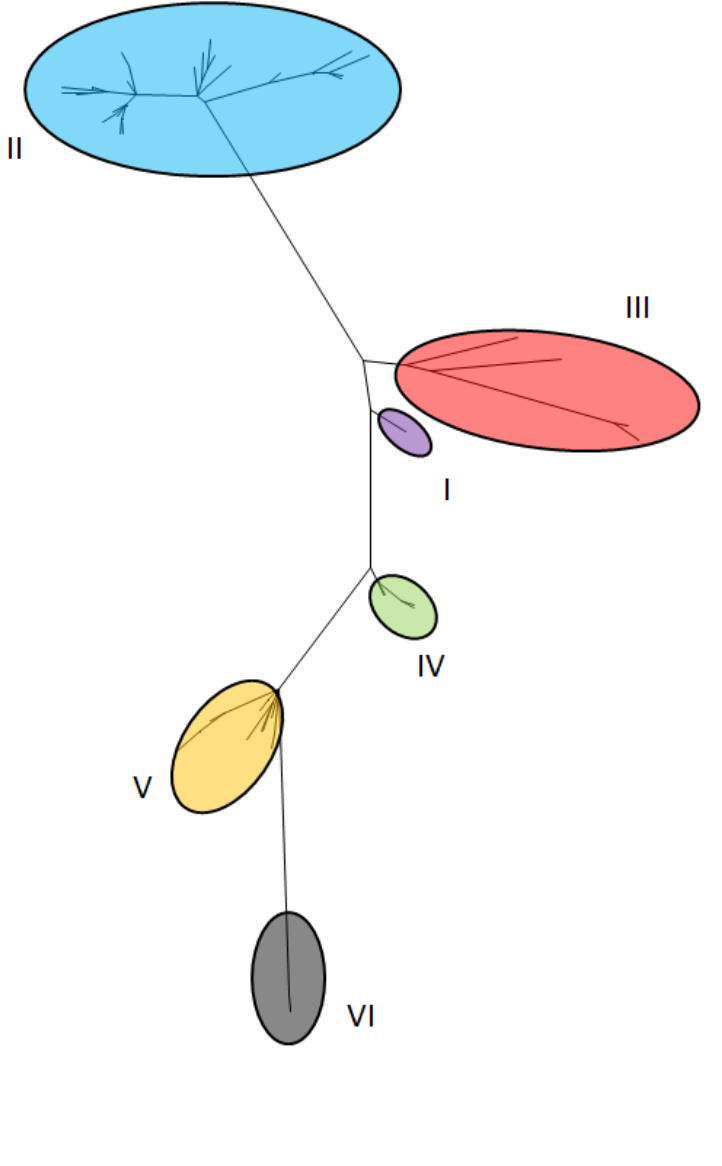
Figure 2. Phylogenetic analysis of BRSV genomic regions. Maximum likelihood phylogenetic trees from the G (A), F (B) and N (C) proteins were generated using representative strains from each BRSV genotype